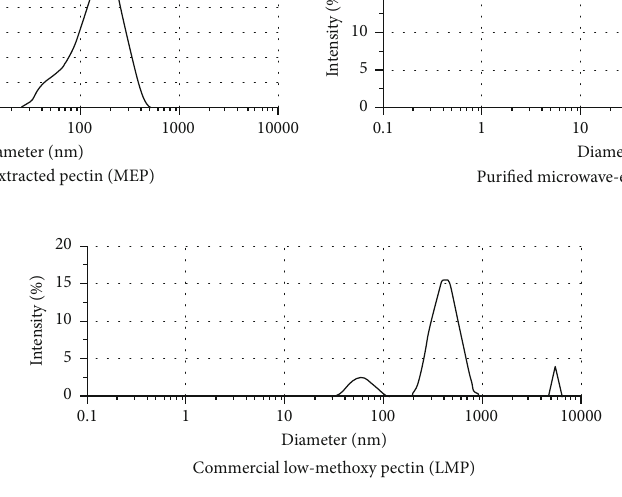
Figure 3: Particle size distribution of 1% ( w / v ) pectin extracted from “ Saba ” banana peel